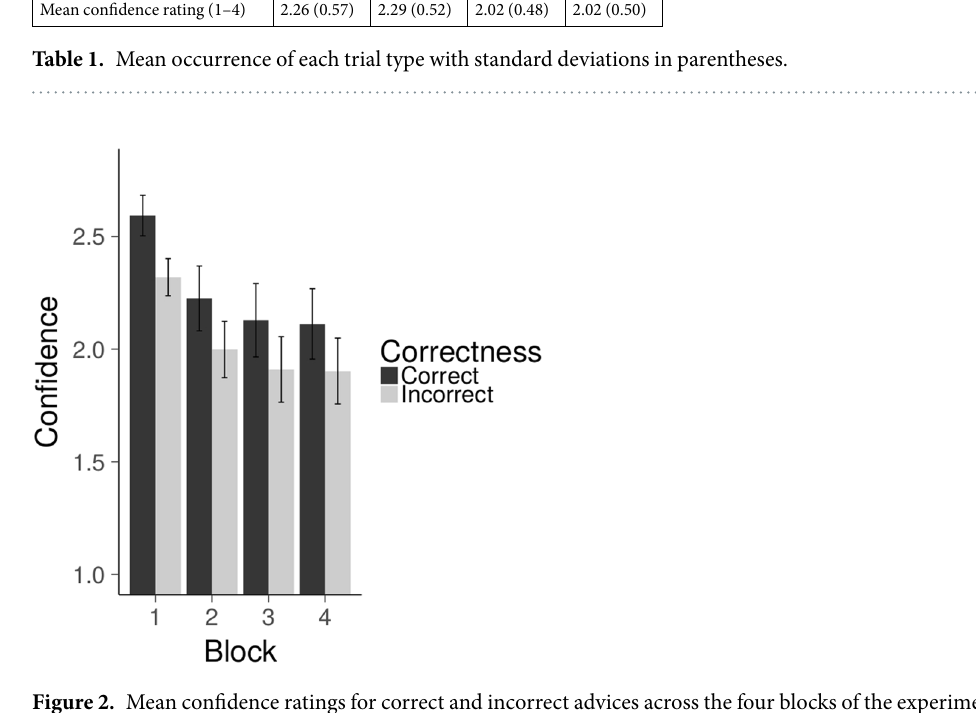
Figure 2. Mean confidence ratings for correct and incorrect advices across the four blocks of the